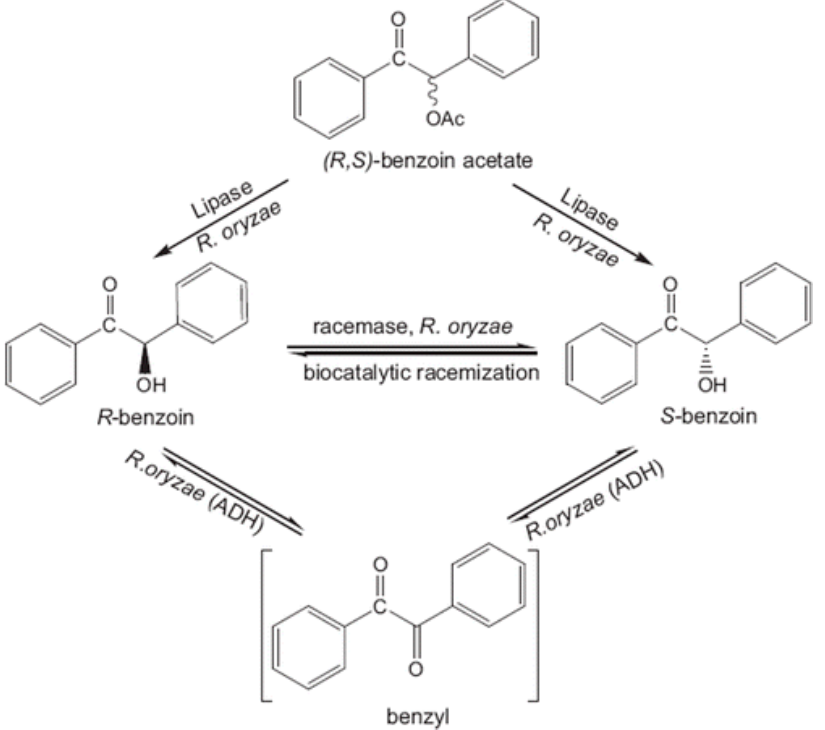
Figure 6. Schematic representation of enantioselective benzoin acetate hydrolysis and deracemisation of benzoin using R. oryzae cells [279].